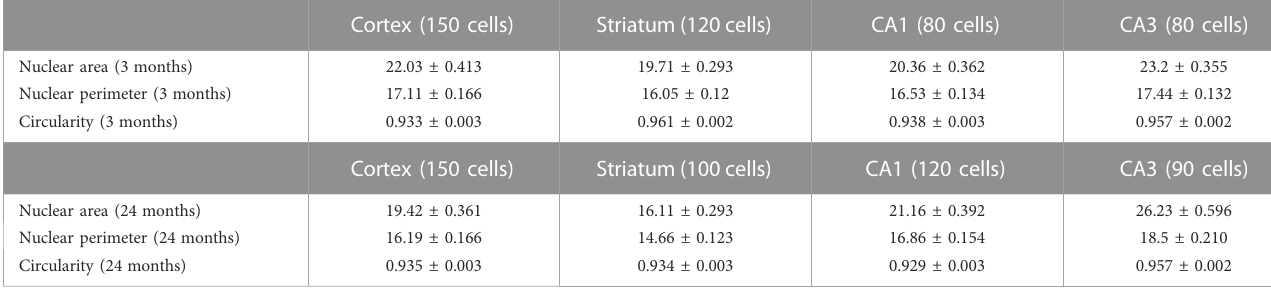
TABLE 1 Nuclear area, perimeter, and circularity of neurons in 3-month and 24-month mice.